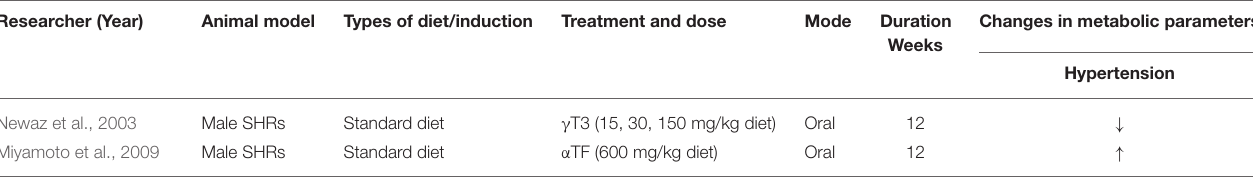
TABLE 4 | The effects of vitamin E on metabolic parameters in hypertensive animal